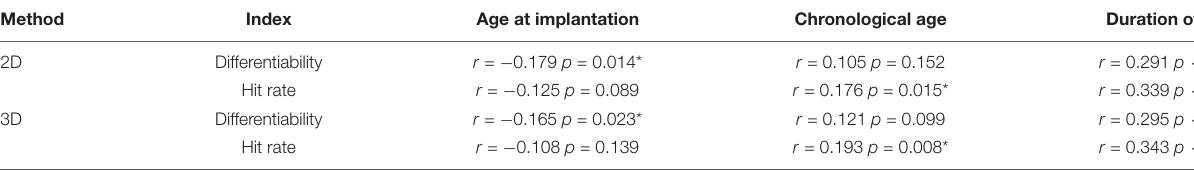
TABLE 1 | The correlation coefficients r and p values under both Method conditions.